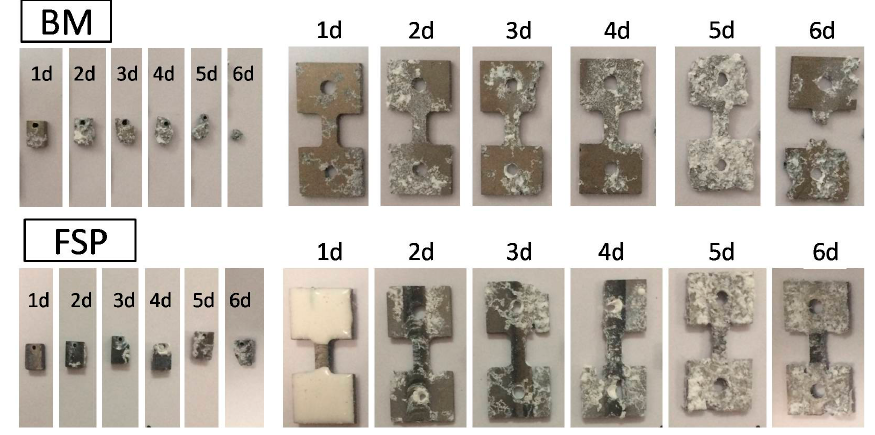
Figure 4. Typical overview surface appearance of specimens with different immersion time intervals in SBF (with corrosion products).